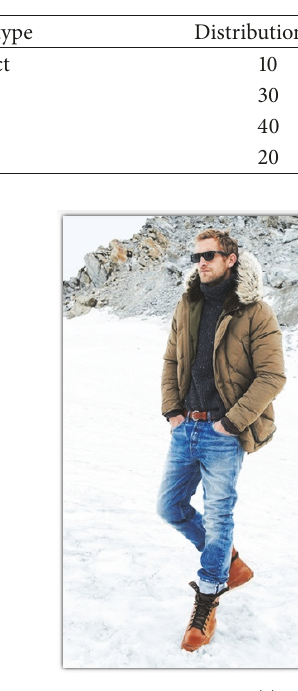
Table 1: Consumer clicks on Hook images from social networks.